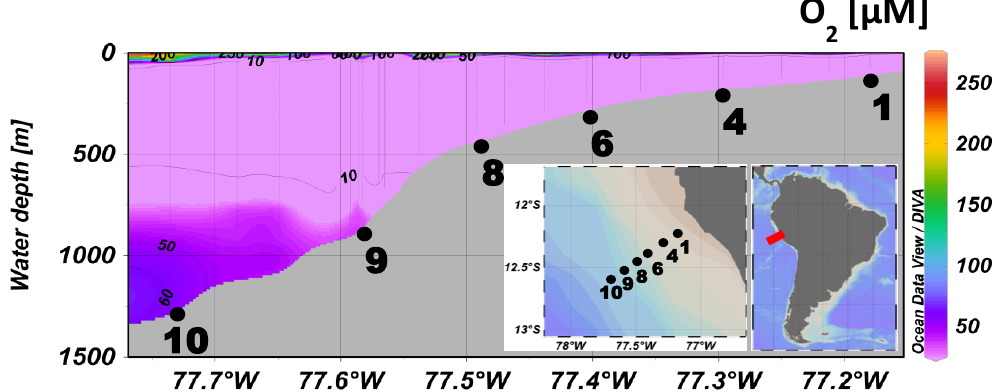
Figure 1. Cross-section of dissolved O 2 concentrations (µM) along the continental margin of the Peruvian OMZ at 12 ◦ S. The vertical lines represent CTD cast for O 2 measurement during the cruise M92. Stations 1 to 10 for multicorer (MUC) sampling are indicated by station numbers according to Dale et al. (2015). Table 1. Sampling deployments, including station number according to Dale et al. (2015), core ID, sampling date and coordinates. Water depth (m) recorded by the ship’s winch and bottom water temperature ( ◦ C) and bottom water O 2 concentration (µM; bdl = below detection limit: 5µM) measured on the